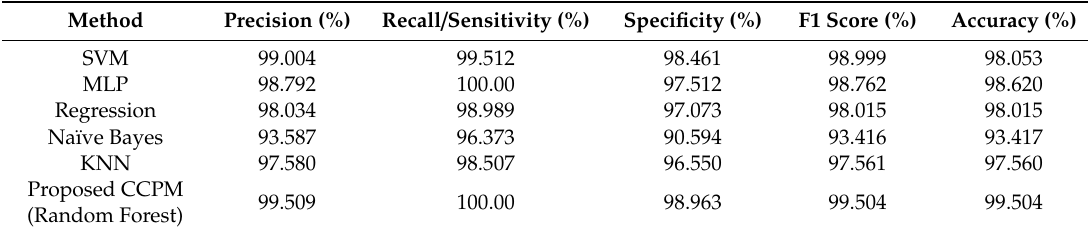
Table 15. Performance evaluation results based on DBSCAN and SMOTETomek for